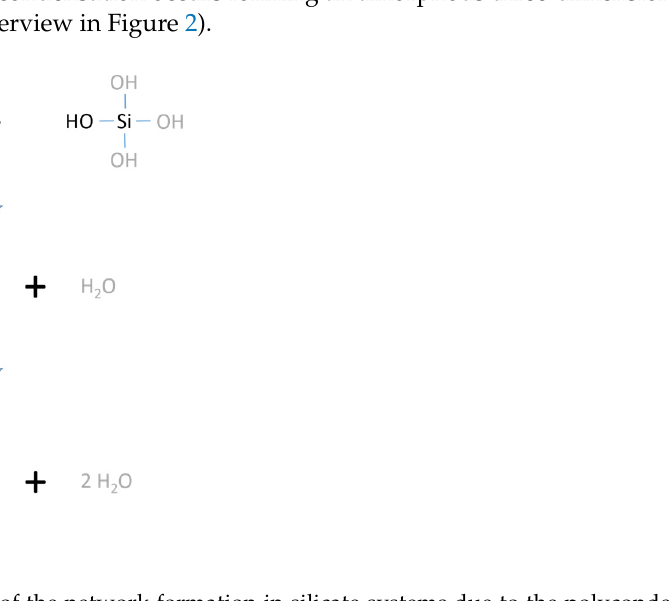
Figure 2. Overview of the network formation in silicate systems due to the polycondensation of silanol groups to siloxanes.